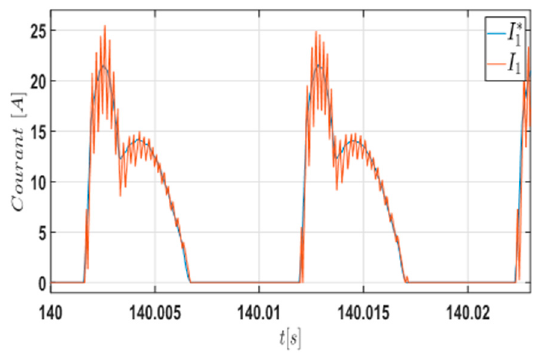
Figure 17. Current response of phase 1 using STSMC.